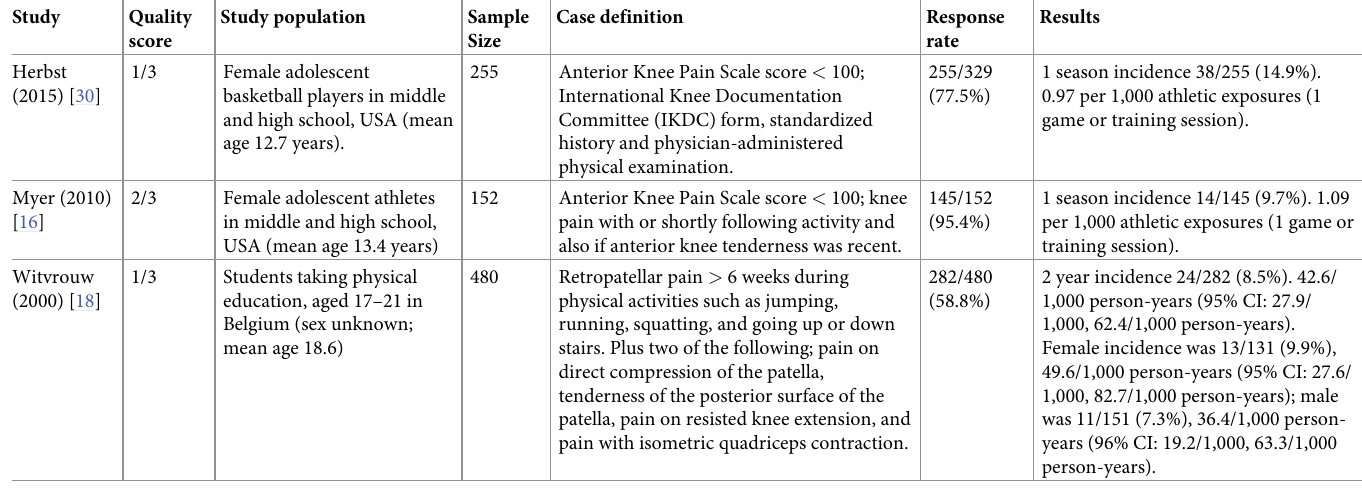
Prevalence. Annual prevalence in the general population was reported as 22.7%, with the annual prevalence in females 29.2% and males 15.5% [83]. Point prevalence in females